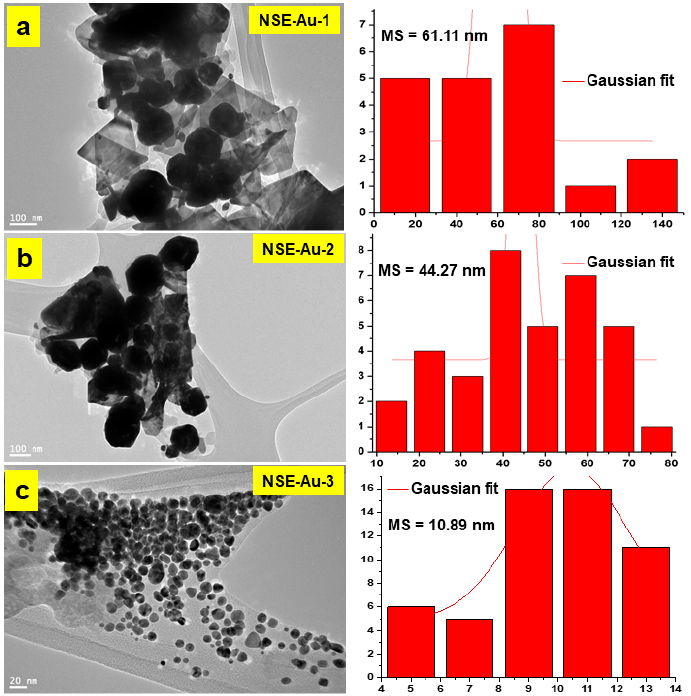
Figure 2. TEM images of Au NPs prepared by using different concentrations of NSE extract, ( a ) Au NPs prepared by using 5 mL of NSE and their size distribution, ( b ) NPs obtained by using 10 mL NSE, and ( c ) Au NPs obtained by using 20 mL of NSE extract and their size distribution. * MS = Mean Size, red line represents Gaussian